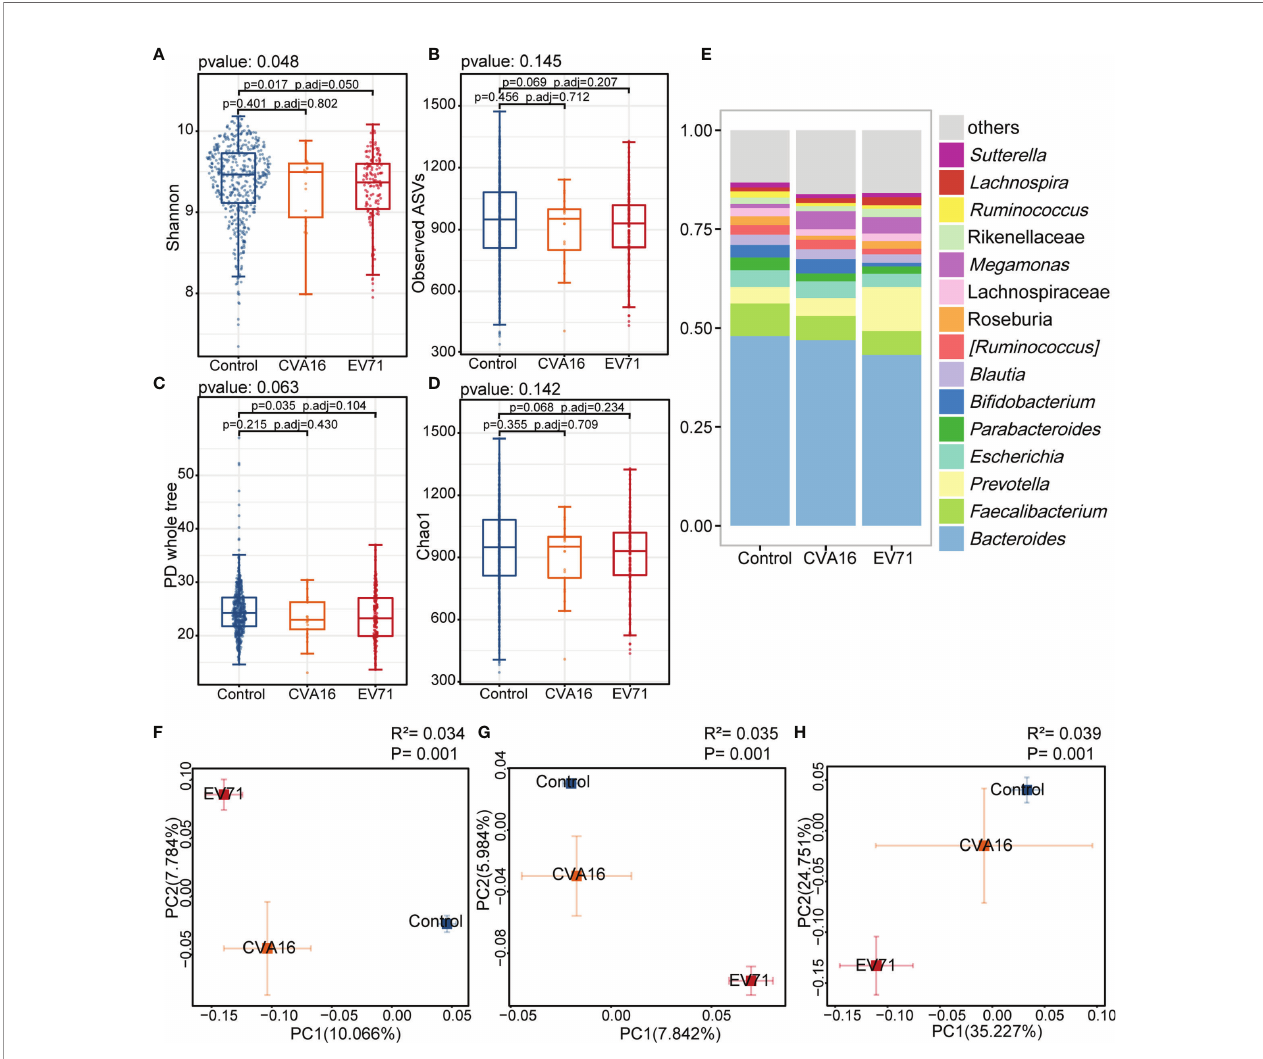
FIGURE 3 | Comparison of the gut microbiota between EV71, CVA16, and control group. (A – D) Alpha diversity. Comparison of alpha-diversity indices (Shannon, observed ASVs, PD whole tree and Chao 1 index) among EV71-infected HFMD, CVA16-infected HFMD and control groups (Kruskal-Wallis tests). (E) Relative abundance of the bacterial microbiota at the genus level among EV71, CVA16, and control group. (F – H) Beta diversity. Principal coordinate analysis (PCoA) based on the Bray-Curtis distance (F) , unweighted UniFrac distances (G) and weighted UniFrac distances (H) revealed that the relationship of bacterial communities among EV71-infected HFMD, CVA16-infected HFMD and control groups. The explanation of diversity captured by the coordinate is given as a